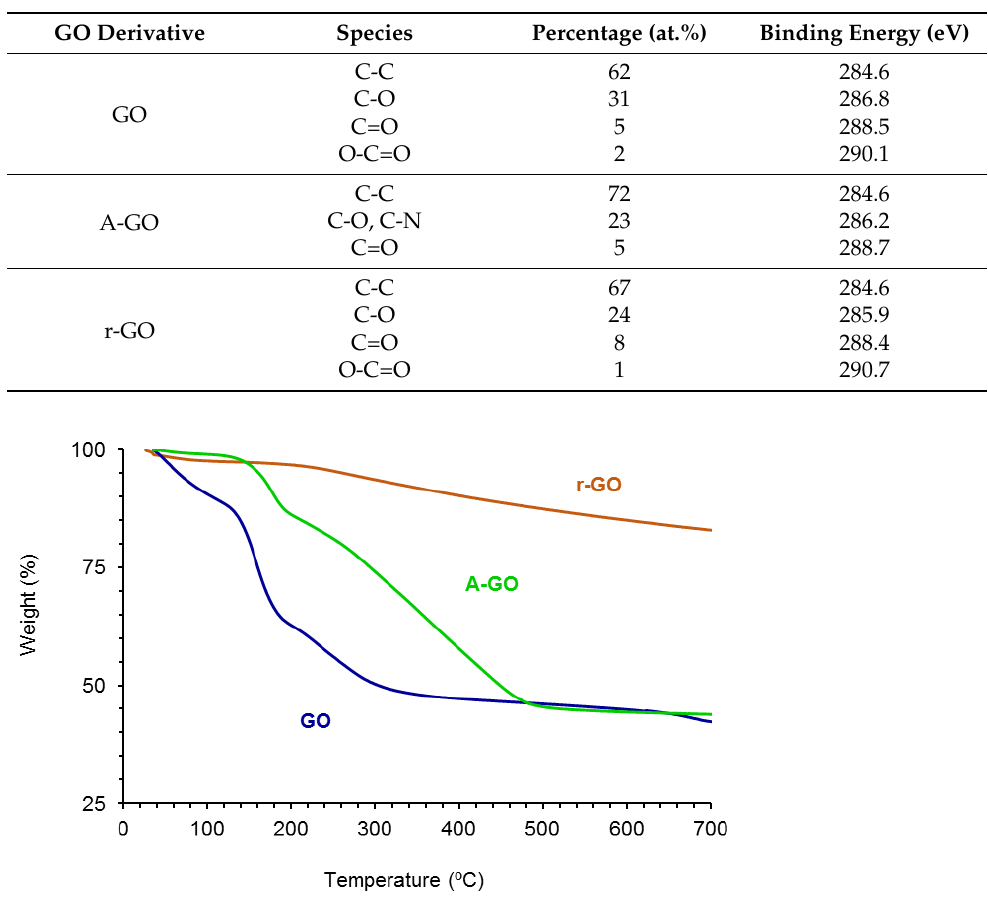
Figure 4. Variation of the weight of the graphene oxide derivatives as a function of the temperature. TGA experiment. Table 3. Amounts of functional groups of the graphene oxide derivatives. TGA